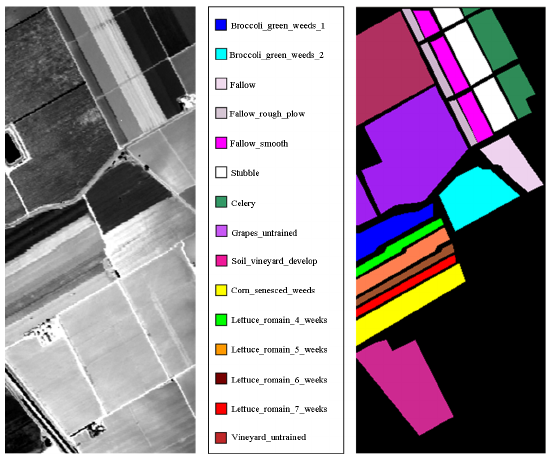
Figure 4: Salinas dataset (left), and available ground truth (right).